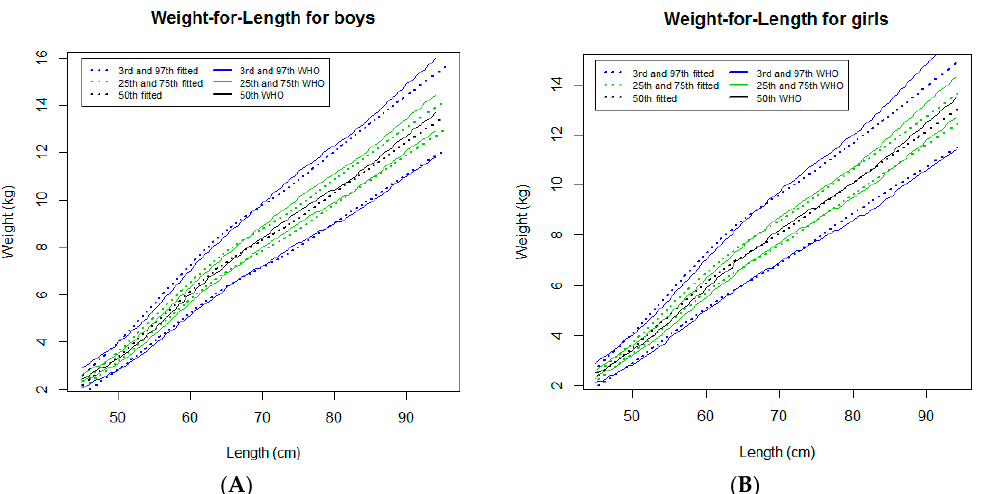
Figure 4. Comparison of the WHO Child Growth Standards (solid lines) with smoothed centile curves (dotted lines) of measured weight-for-length for boys ( A ) and girls ( B ) from the neonatal period to 24 months of